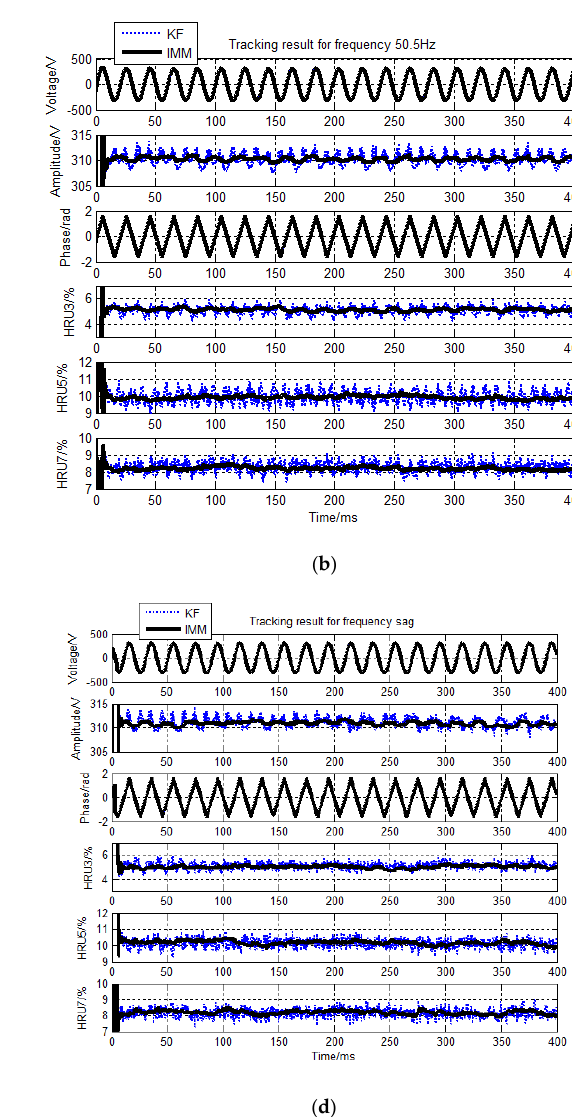
Figure 14. Experiment tracking results for voltage frequency heavy fluctuations. ( a ) Experiment tracking results for frequency 49.5 Hz; ( b ) Experiment tracking results for frequency 50.5 Hz; ( c ) Experiment tracking results for frequency swell; ( d ) Experiment tracking results for frequency sag.